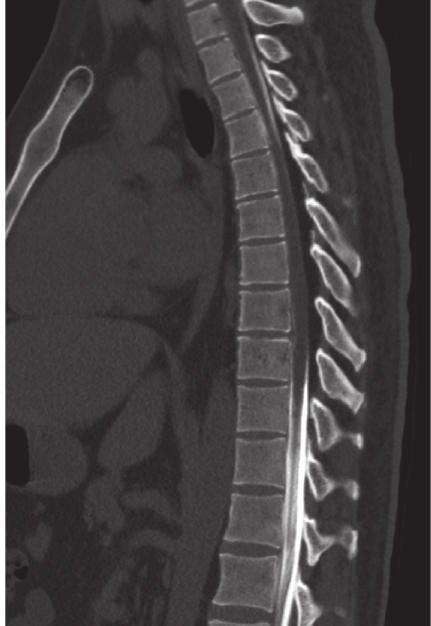
Figure 2: CT myelogram showing obstruction of CSF flow extending from T4 to T9 vertebrae.